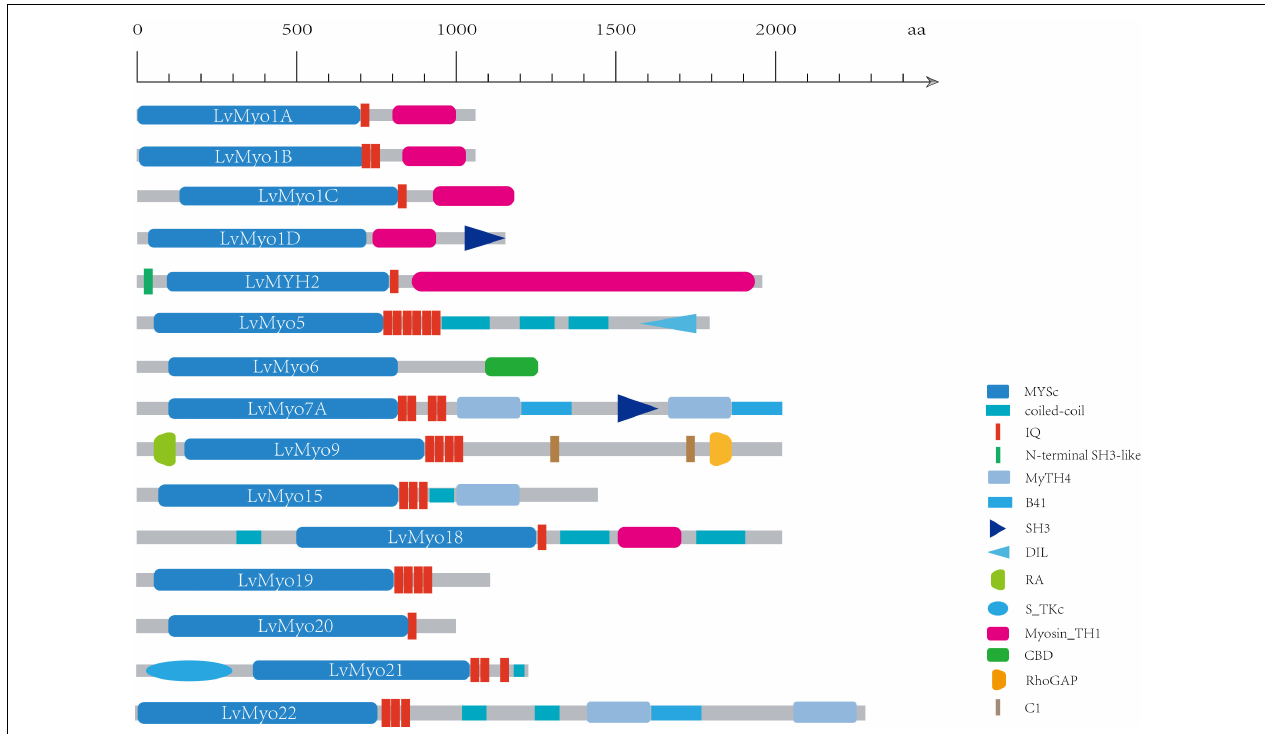
FIGURE 3 | Schematic diagram of shrimp unconventional myosin structures. The putative domains or motifs were identified using the Pfam and SMART databases with the default parameters. MYSc, Myosin head, large ATPase; IQ, isoleucine-glutamine motif; DIL, dilute; CBD, cargo binding domain; MyTH4, myosin tail homology 4; B41, band 4.1, ezrin, radixin, and moesin; SH3, src homology 3; RA, Ras association (RalGDS/AF-6) domain; C1, Protein kinase C conserved region 1; RhoGAP, Rho GTPase-activating protein; S_TKC, Serine/Threonine protein kinases, catalytic domain. Myosin_TH1, myosin tail homology 1.